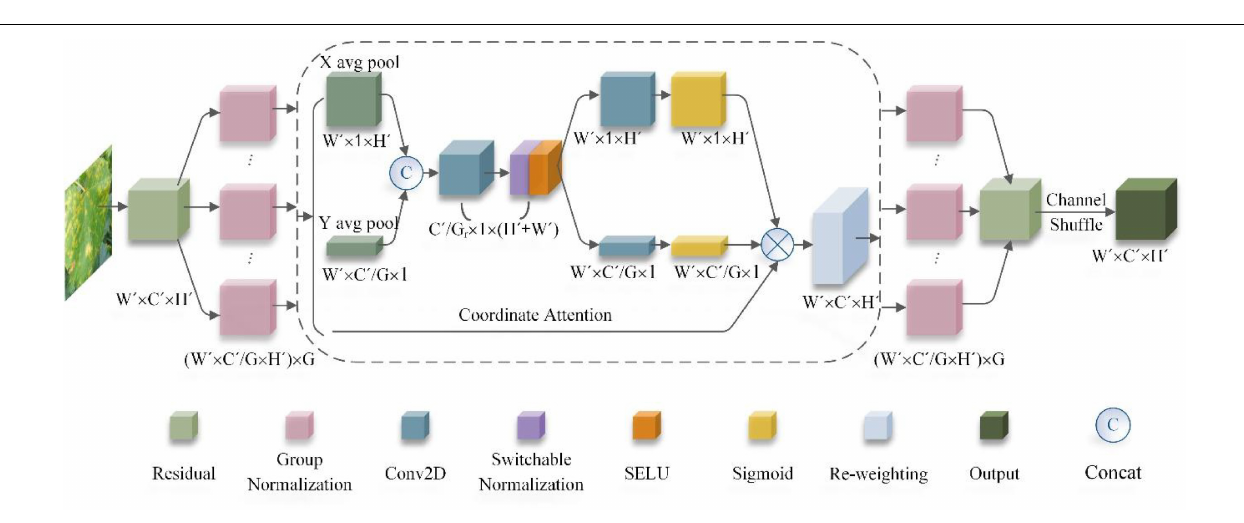
FIGURE 5 | Coordinate attention shuffle mechanism (CASM) module